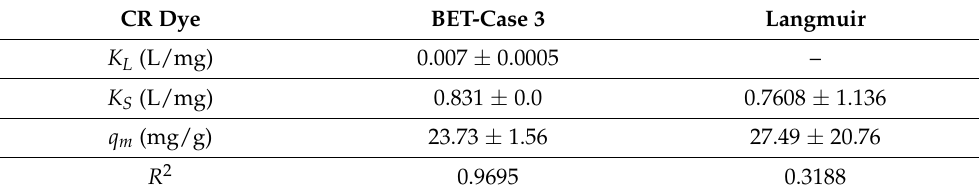
Table 2. Calculated for CR parameters of isotherm for different adsorption models.